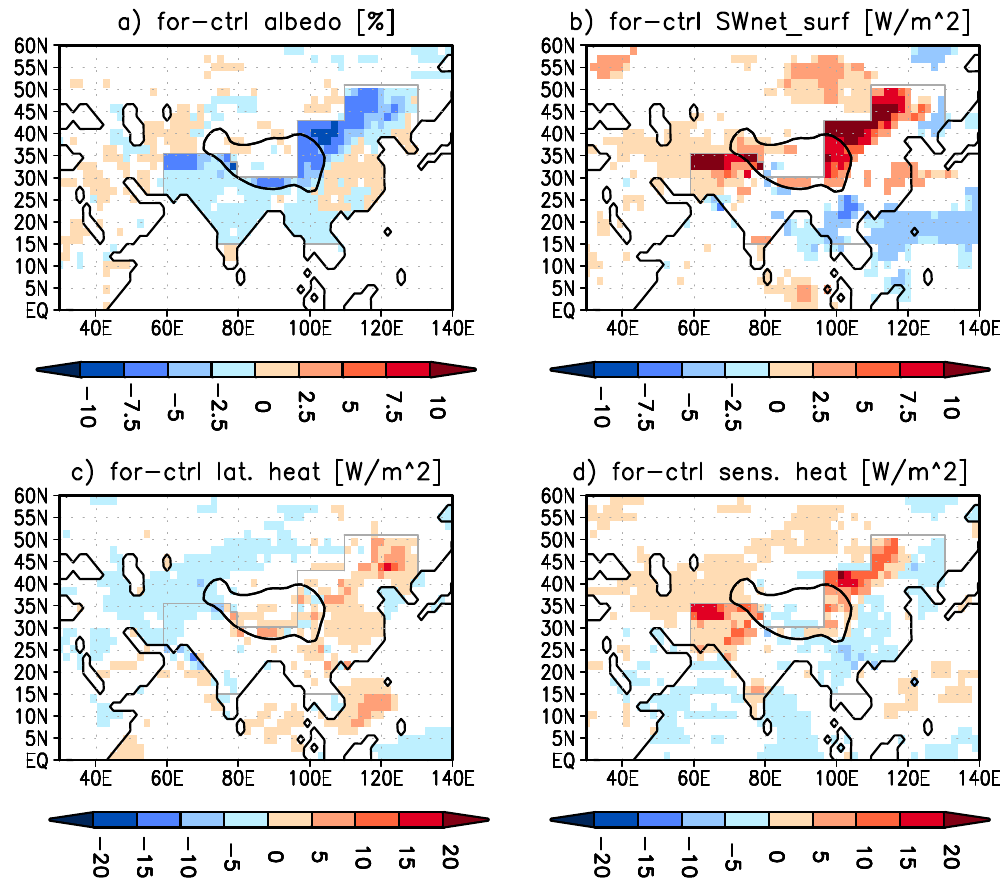
Fig. 9. Simulated change of different parameters influencing the temperature change between the afforestation experiment (for) and the control run (ctrl), averaged over the monsoon season. (a) surface albedo in %; (b) net surface shortwave radiation in Wm − 2 ; (c) latent heat flux in Wm − 2 ; (d) sensible heat flux in Wm − 2